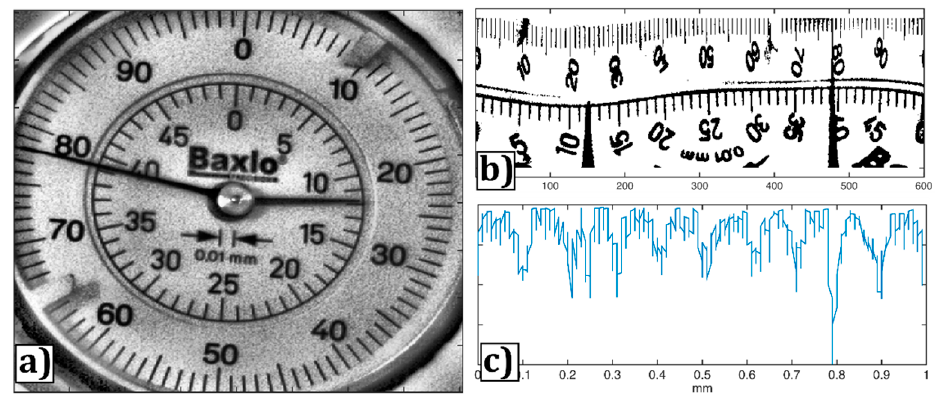
Figure 11. ( a ) Region of interest (ROI) of a frame of the recorded sequence by the camera focusing on the contact measurer. ( b ) Binarized and Cartesian-to-Polar transformed image of the ROI. ( c ) Sum of intensity of the pixels in Figure 11b by columns. Columns have previously been discretized to cover the range from 0 to 1 mm with steps of 0.01 mm, according to the accuracy of the device.